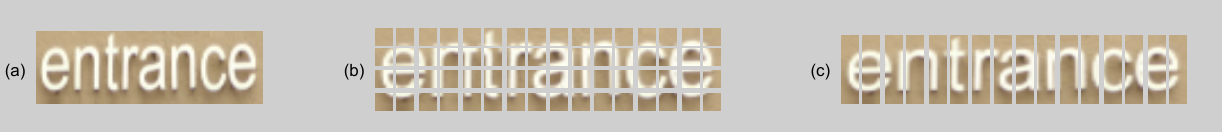
Figure 1. Difference between 1 and D split and 2-D split. ( a ) A rectified text image. ( b ) 2-D split: The text image is split into square patches proposed in the ViT-like backbone. ( c ) 1-D split: The text image is split into rectangle patches whose height is the same as the height of the rectified image. Using the same patch dimension, the 1-D split is more efficient than the 2-D